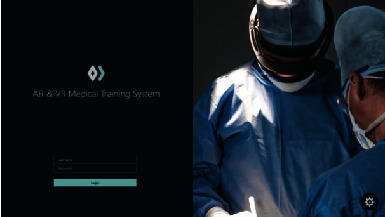
System login screen.